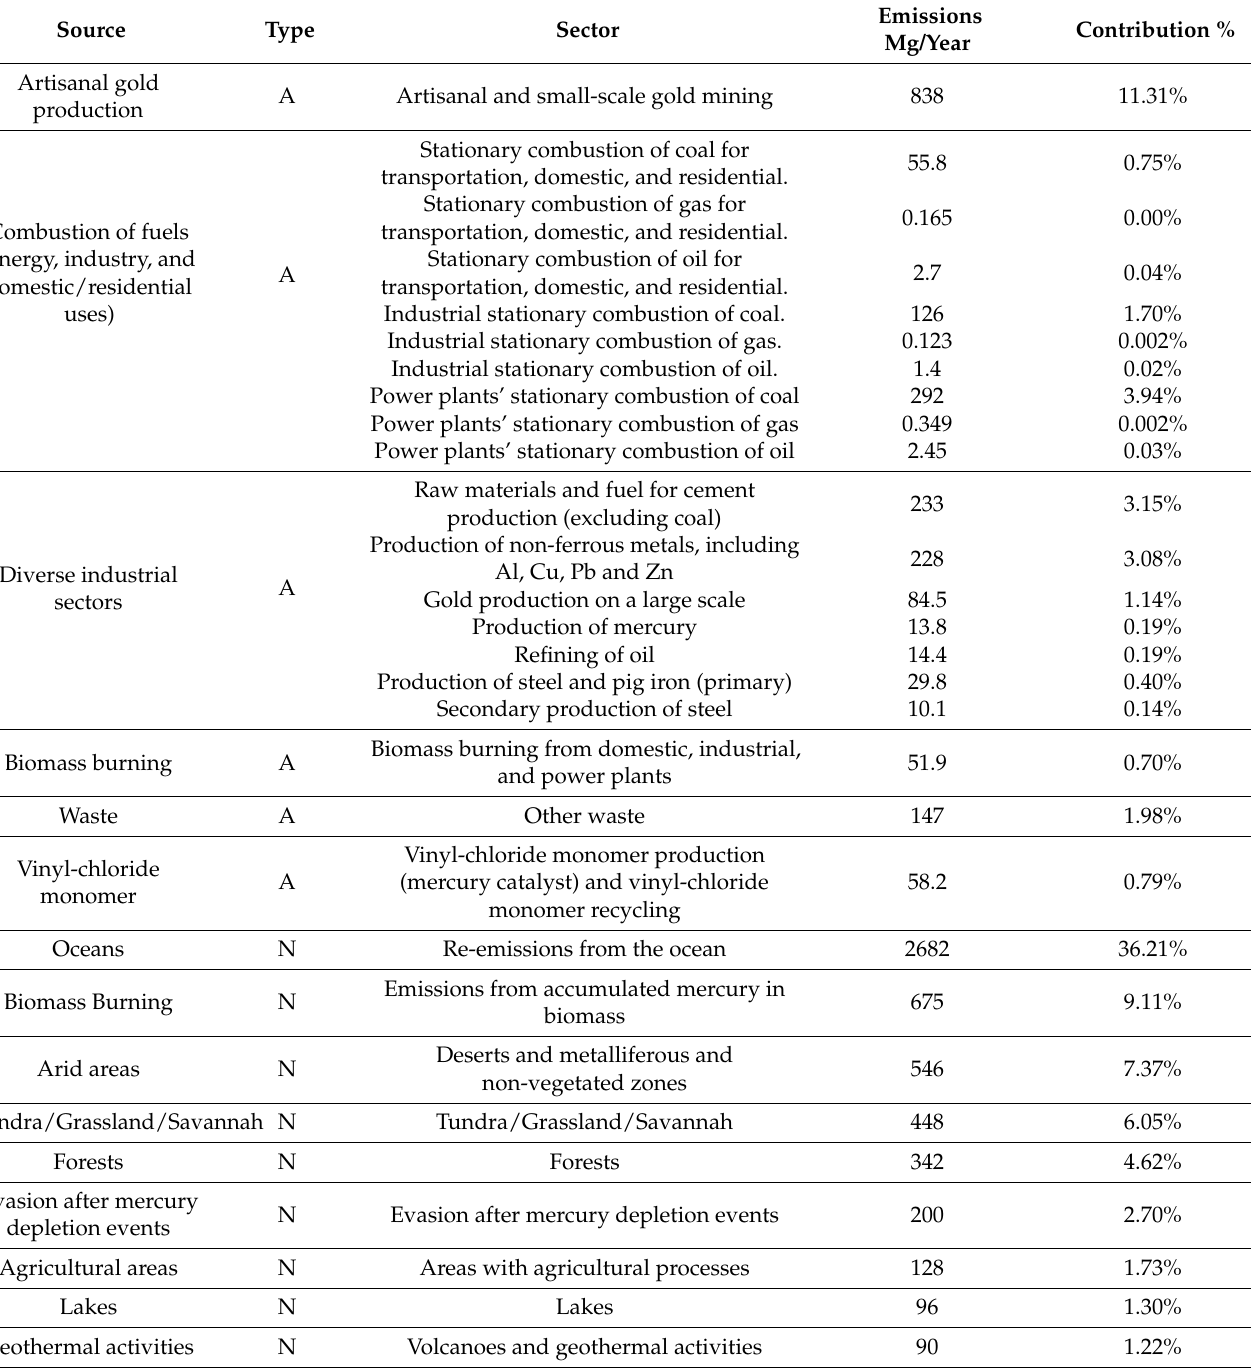
Table 1. Main sectors of anthropogenic mercury emissions (A) and natural emissions (N). The anthropogenic emissions to the atmosphere are for 2015 and based on 2200 Mg/year and the table shows 99.53% of the total anthropogenic emissions [21]. The natural emissions are for 2008 and based on 5207 Mg/year; adapted from Pirrone et al. (2010)